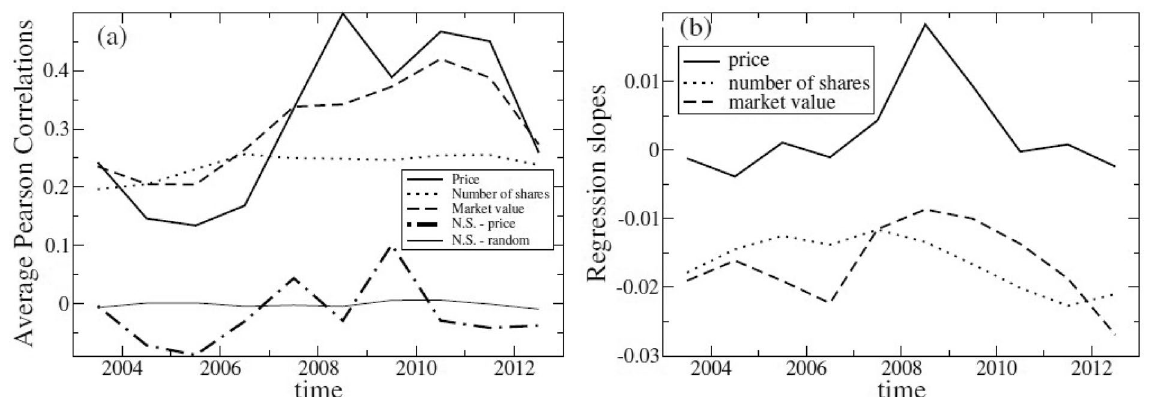
Figure 4. Correlations. Plot ( a ) shows the dependence of average correlations of prices, number of shares and market values of funds’ assets over time and the correlations between the number of shares and the corresponding price changes (N.S.-price) as well as the correlations between the randomized time series (N.S.- random). Plot ( b ) is the dependence of regression slopes of fund sizes for average correlations of the same quantities of Plot ( a